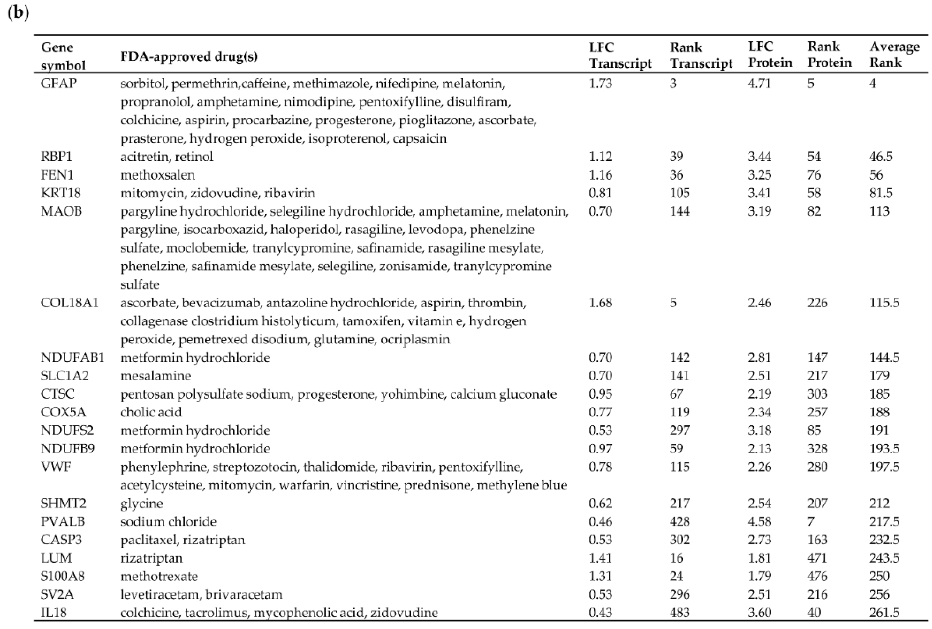
Figure 5. The druggable grade III meningioma proteome. ( a ) Proteins with increased concordant expression in grade III vs. grade I meningiomas also associated with Food and Drug Administration (FDA)-approved drugs are displayed. ( b ) Top 20 concordantly expressed proteins based on average rank value and their associated FDA-approved drugs following submission to the drug–gene interaction database (DGIdb, v3.0). Table S6 provides details of transcripts/proteins associated with FDA-approved drugs.